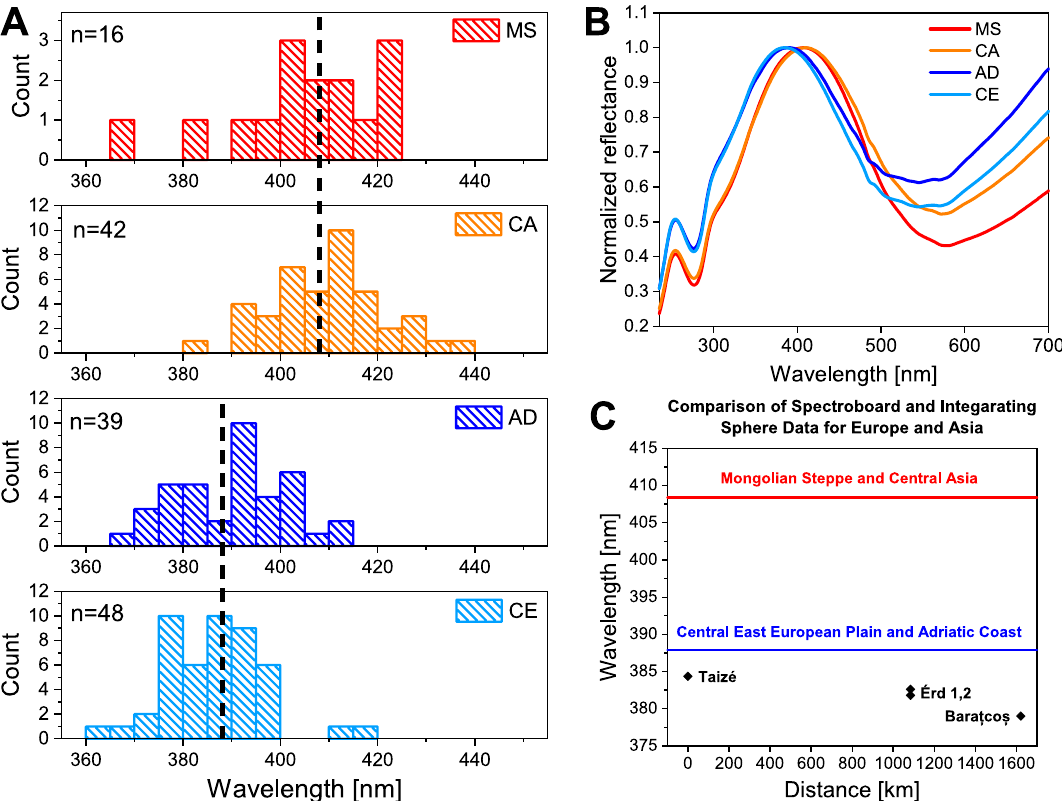
Figure 5. Comparison of spectroboard and integrating sphere measurements for Europe and Asia. ( A ) The histograms of the spectral position of reflectance maxima measured with spectroboard (wings not detached) are shown for four test regions: Mongolian Steppe (MS); Central Asia (CA); Adriatic Coast (AD); Central East European Plain (CE) from Ref. 34 . Number of specimens included in each region is indicated in each histogram in the right upper corner. ( B ) The spectra measured with spectroboard in normal incidence on museum samples averaged by the four test regions from Ref. 34 . In panel ( C ), the red line stands for the average of MS and CA regions, the blue line for the average of AD and CE regions (marked by broken lines in the left panel), the black diamonds show the spectral position of averaged reflectance maxima measured with the integrating sphere on the detached wings of the butterflies from the four samples regions: TZ, EF, EP, and